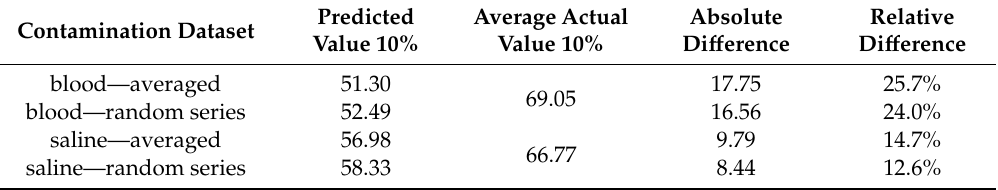
Table 8. Compressive strength prediction accuracy for DLN taught in the range of 0–8% of contamination. Contamination